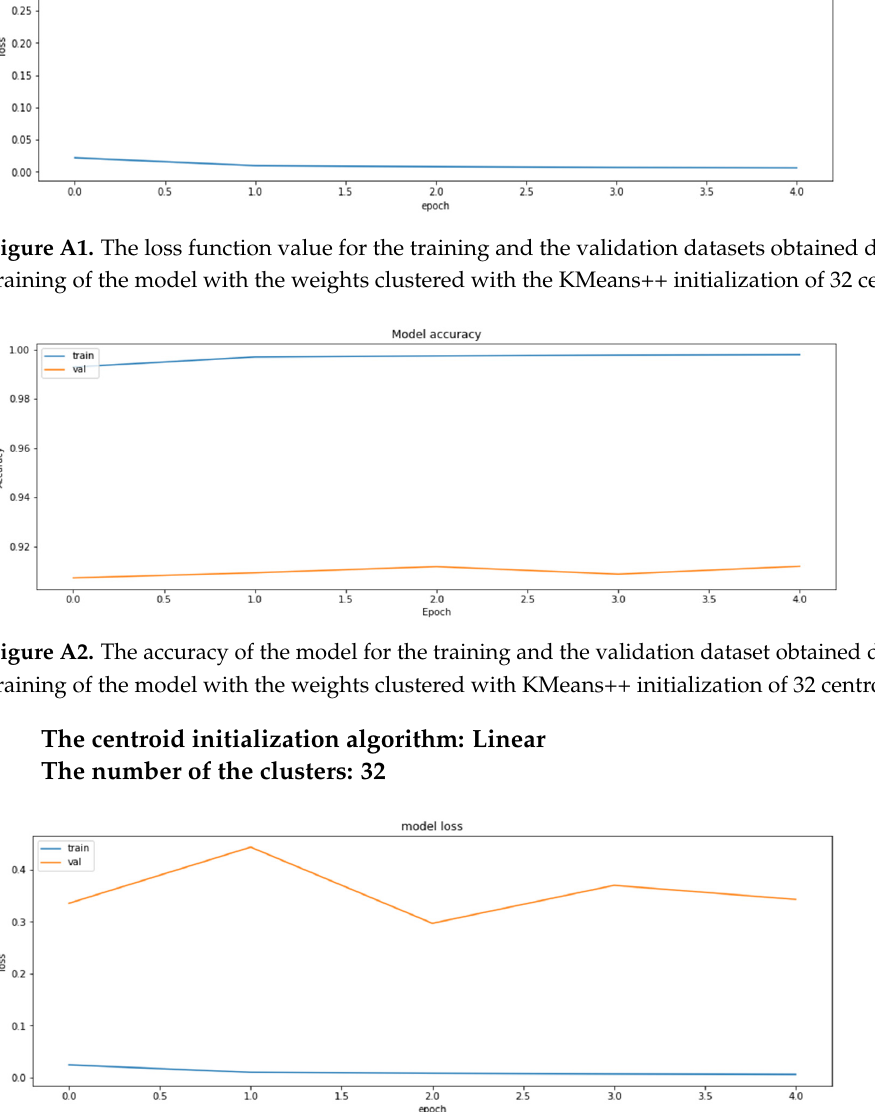
Figure A3. The loss function values for the training and the validation datasets obtained during the training of the model with the weights clustered with the linear initialization of 32 centroids.